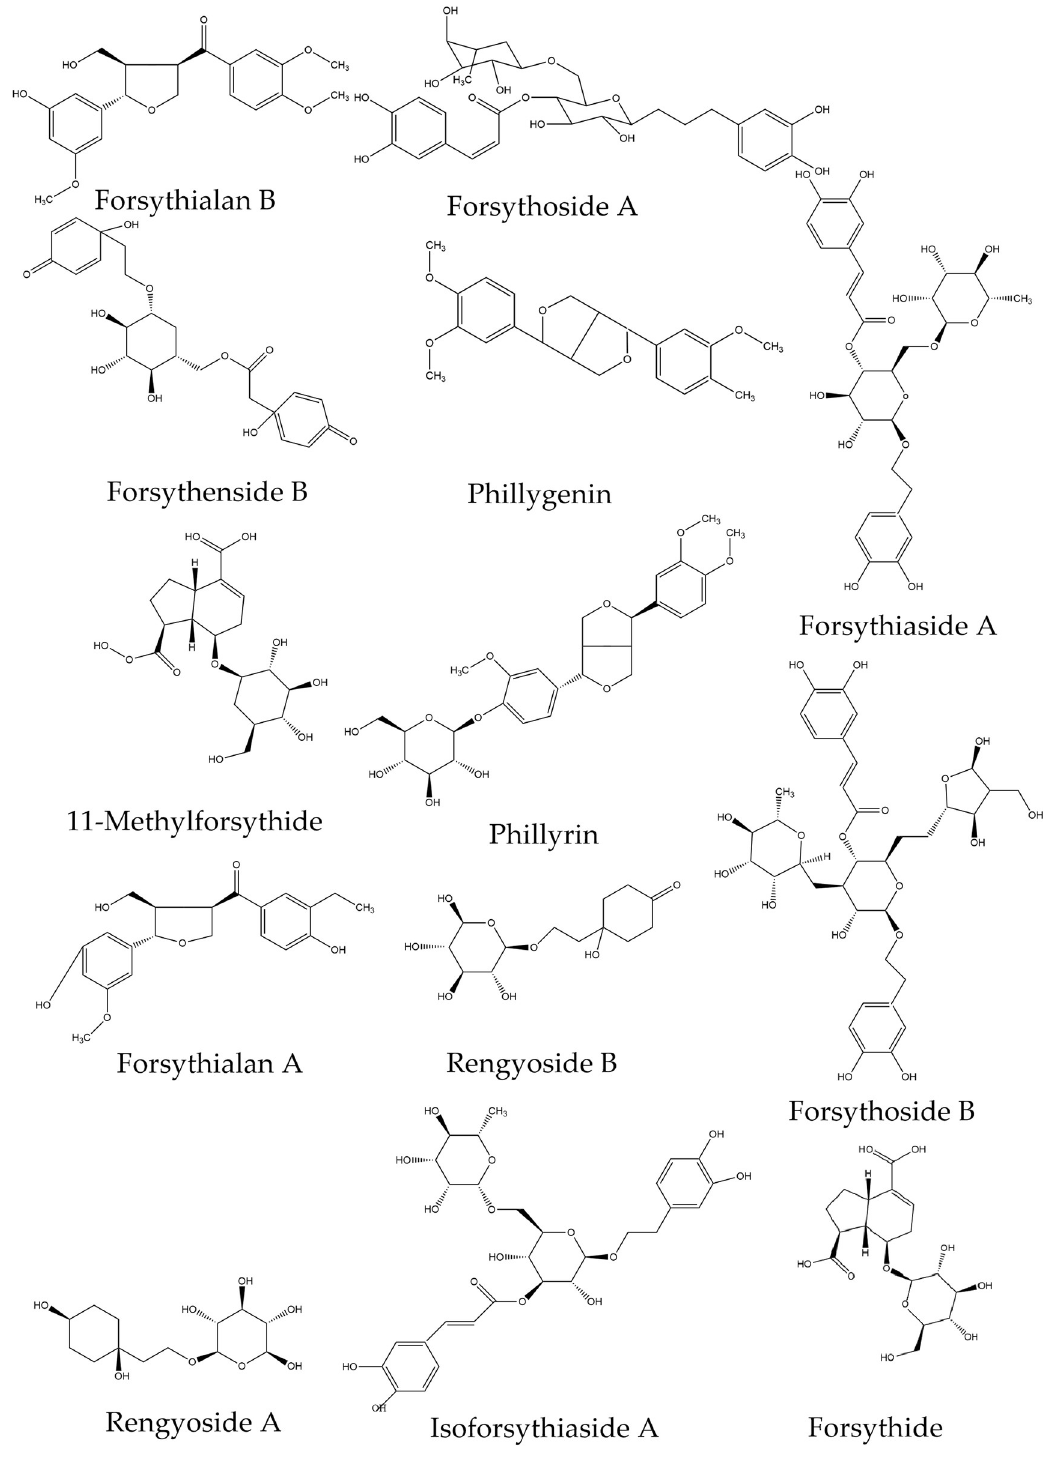
Fig 5. Molecular structures of Forsythia related